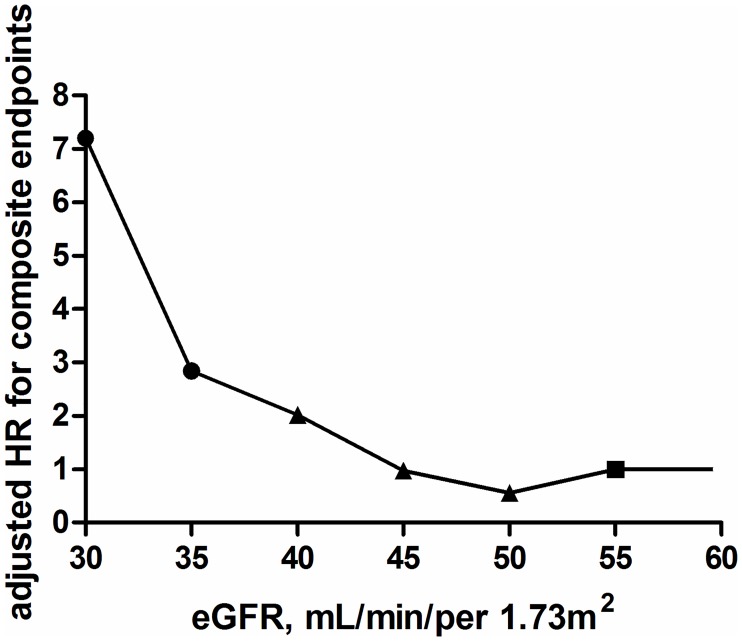
Hazard ratios of composite endpoints in IgAN patients with CKD stage 3 with different eGFR.The reference was eGFR 55–60 mL/min/per 1.73 m2. The number of patients in each group was as follows: 55 to < 60: n = 70; 50 to <55: n = 77; 45 to < 50: n = 63; 40 to < 45: n = 67; 35 to < 40: n = 58; 30 to < 35: n = 55. HRs adjusted for age, sex, systolic blood pressure, diastolic blood pressure and proteinuria. Dots represent statistical significance, triangles represent non-significance, and squares represents the reference. Composite endpoints: doubling of serum creatinine, ESRD, or all-cause mortality. Abbreviations: IgAN, IgA nephropathy; CKD, chronic kidney disease; eGFR, estimated glomerular filtration rate; HR, hazard ratios.